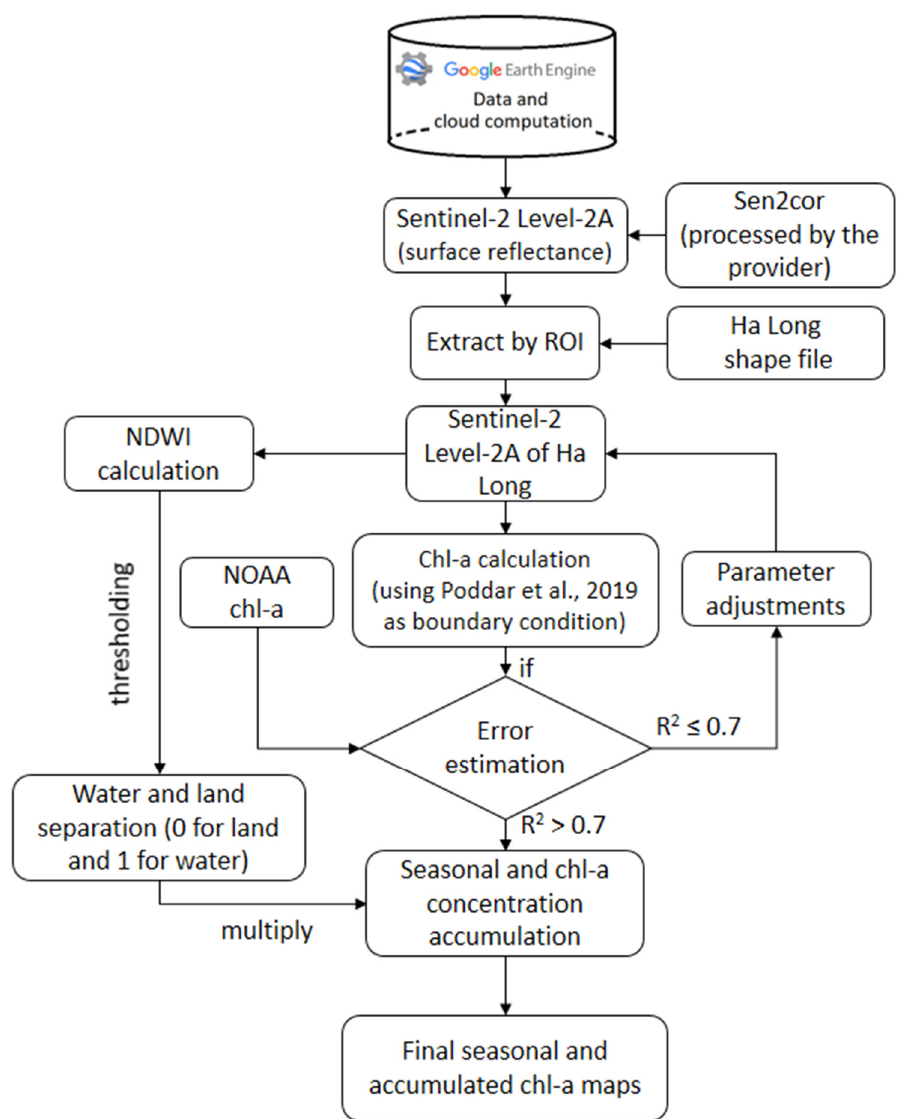
Figure 2. Method workflow chart for estimating and generating chlorophyll-a (chl-a) maps; NDWI is the normalized difference water index, NOAA is the short form of National Oceanic and Atmospheric Administration (USA), R 2 is the coefficient of determination, and ROI stands for the region of